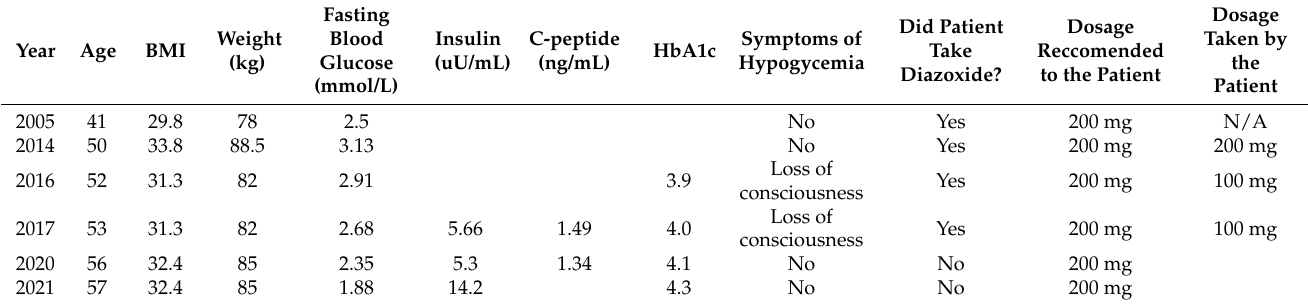
Table 2. Summary of metabolic profile results, concomitant symptoms of hypoglycemia and treatment in index patient IA.